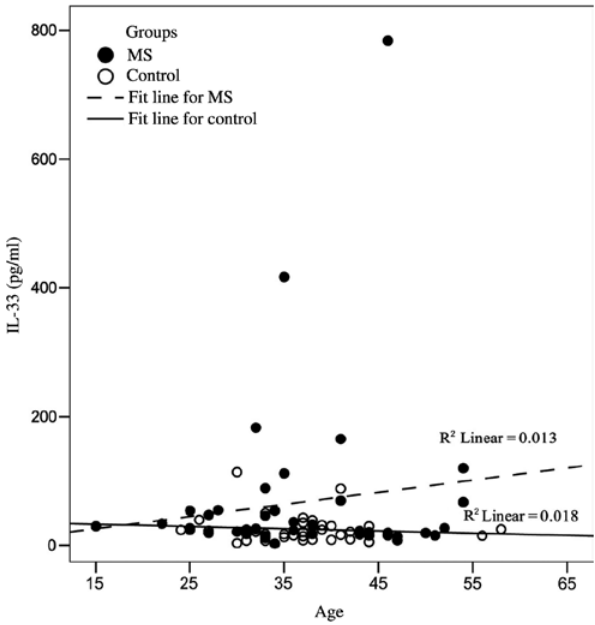
Figure 1: Plasma IL-33 levels based on age in the case and control groups.